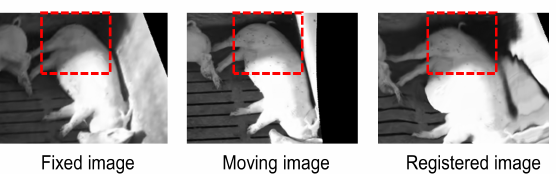
Figure 8. The proposed method retains the appearance features specific to moving images while aligning moving images to fixed images.